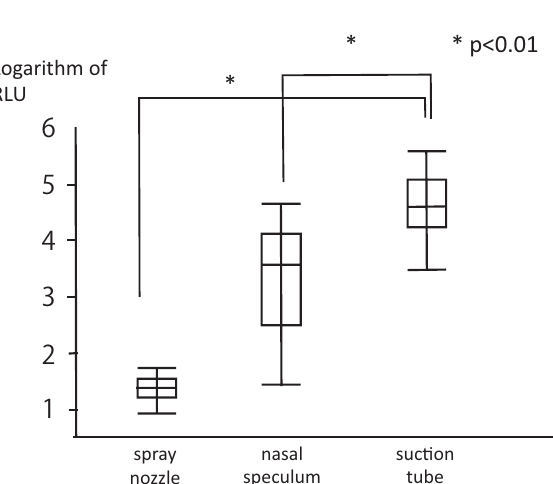
F i g . 5 Comparison of lo g arithm of RLU scores bet w een nasal spra y nozzles, nasal spec u l u ms and s u ction t u bes after u se The RLU scores (mean ± SD) after patient u se is : nasal spra y nozzles, 30 ± 28.7;